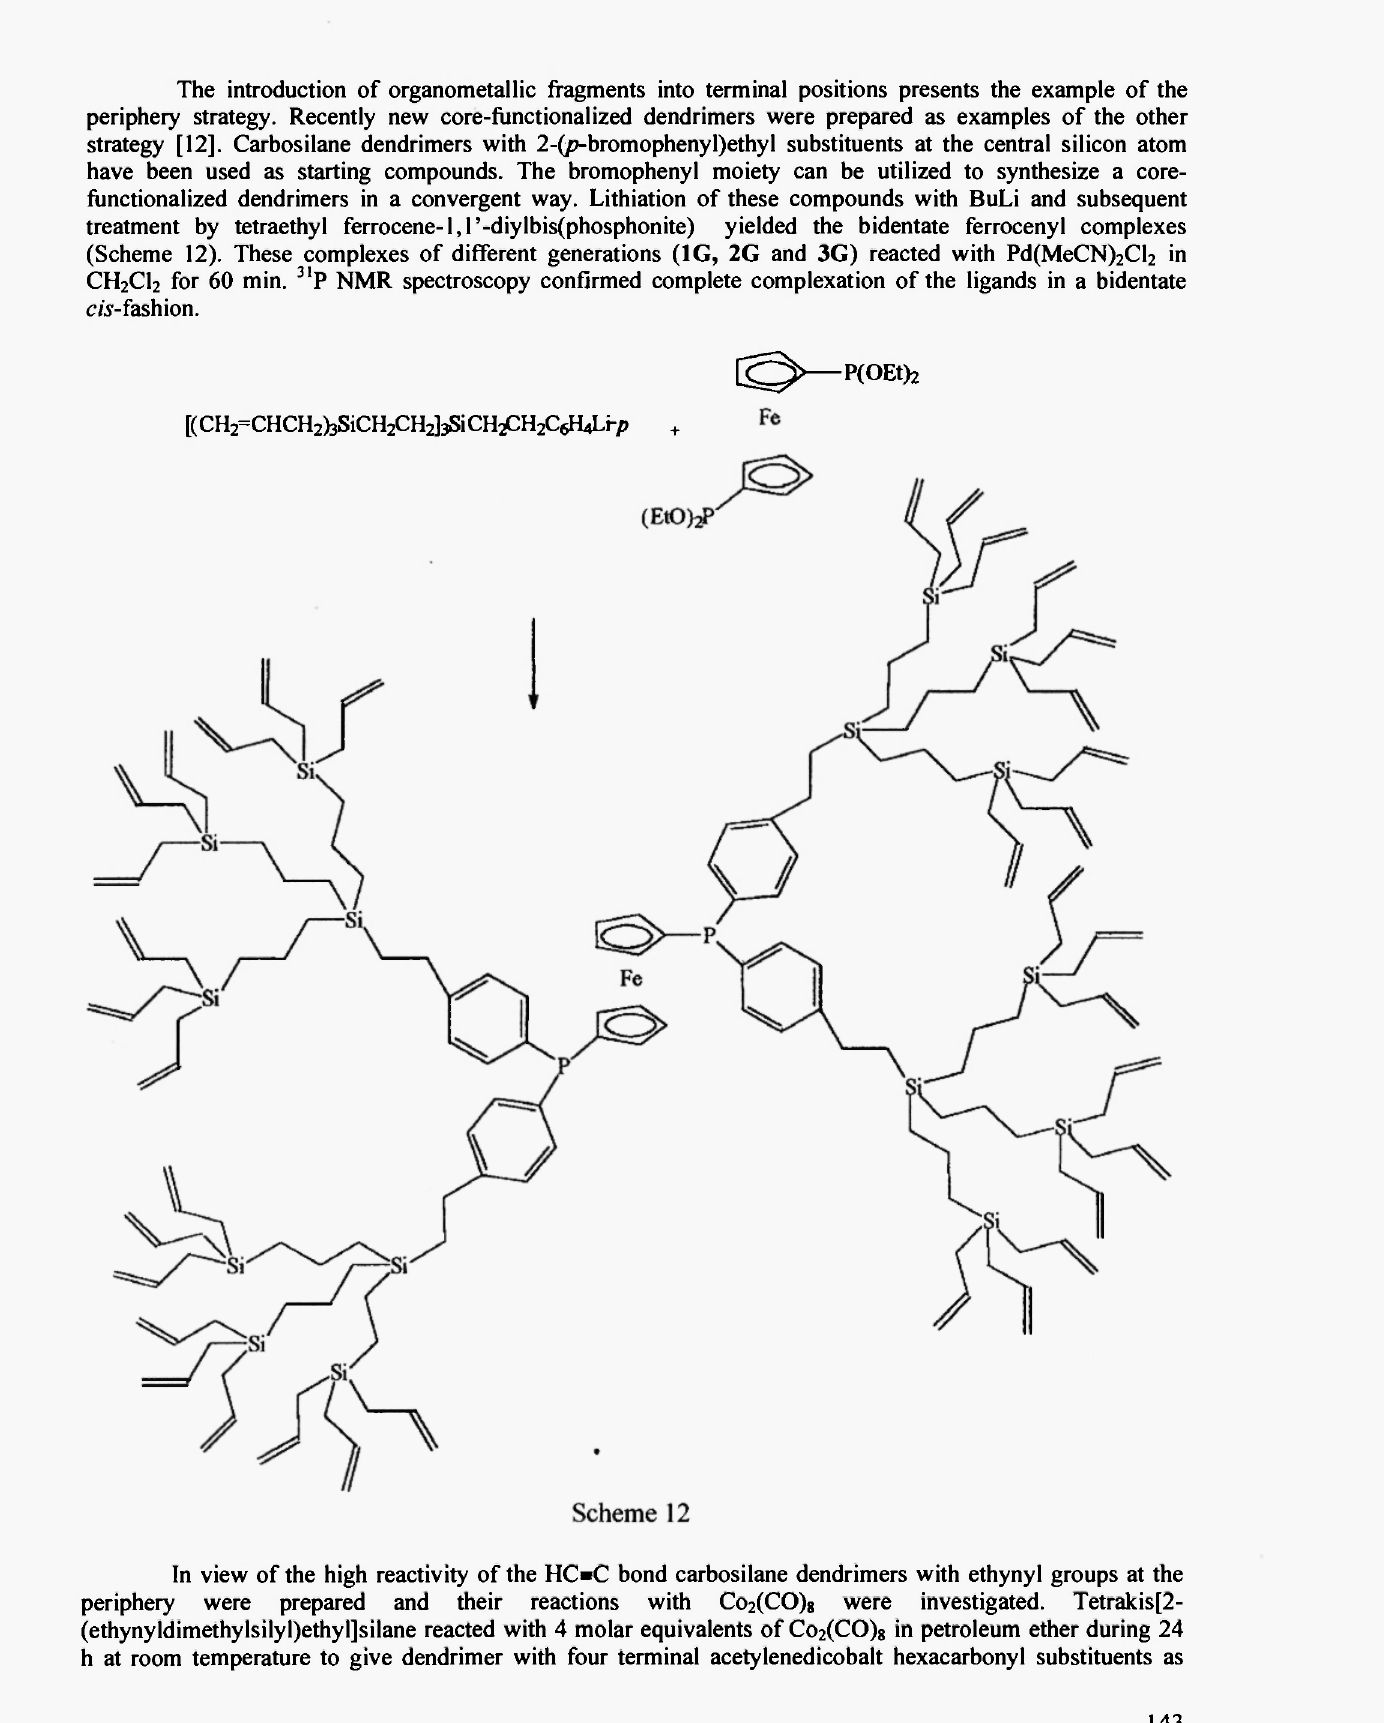
The introduction of organometallic fragments into terminal positions presents the example of the periphery strategy. Recently new core-fiinctionalized dendrimers were prepared as examples of the other strategy [12]. Carbosilane dendrimers with 2-(/>bromophenyl)ethyl substituents at the central silicon atom have been used as starting compounds. The bromophenyl moiety can be utilized to synthesize a core- functionalized dendrimers in a convergent way. Lithiation of these compounds with BuLi and subsequent treatment by tetraethyl ferrocene-l,l'-diylbis(phosphonite) yielded the bidentate ferrocenyl complexes (Scheme 12). These complexes of different generations (IG, 2G and 3G) reacted with Pd(MeCN) 2 Cl 2 in CH 2 C1 2 for 60 min. 31 P NMR spectroscopy confirmed complete complexation of the ligands in a bidentate